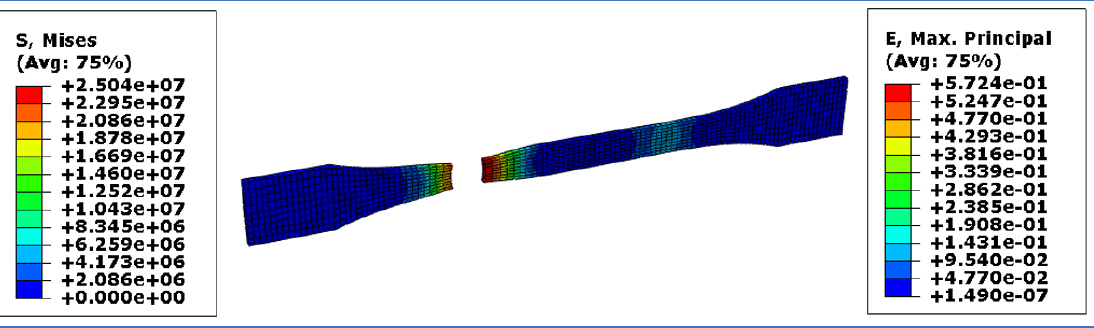
Figure 4. Von Mises stress and principal strain developed on the simulated tensile sample of the PLA-coconut fibre with 3 wt.% coconut.